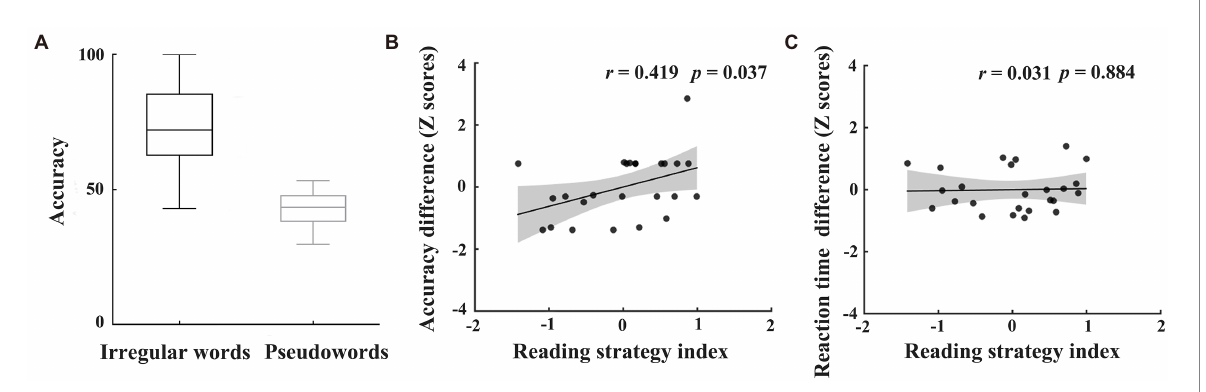
FIGURE 2 Results of individuals’ reading pathway preference. The accuracies of irregular words and regular pseudowords (A) . The correlations between reading strategy index and difference in accuracy (B) or reaction time (C) between assembled and addressed characters during the word naming task after fMRI scan. The values of accuracy or reaction time in panels B and C were transformed into Z